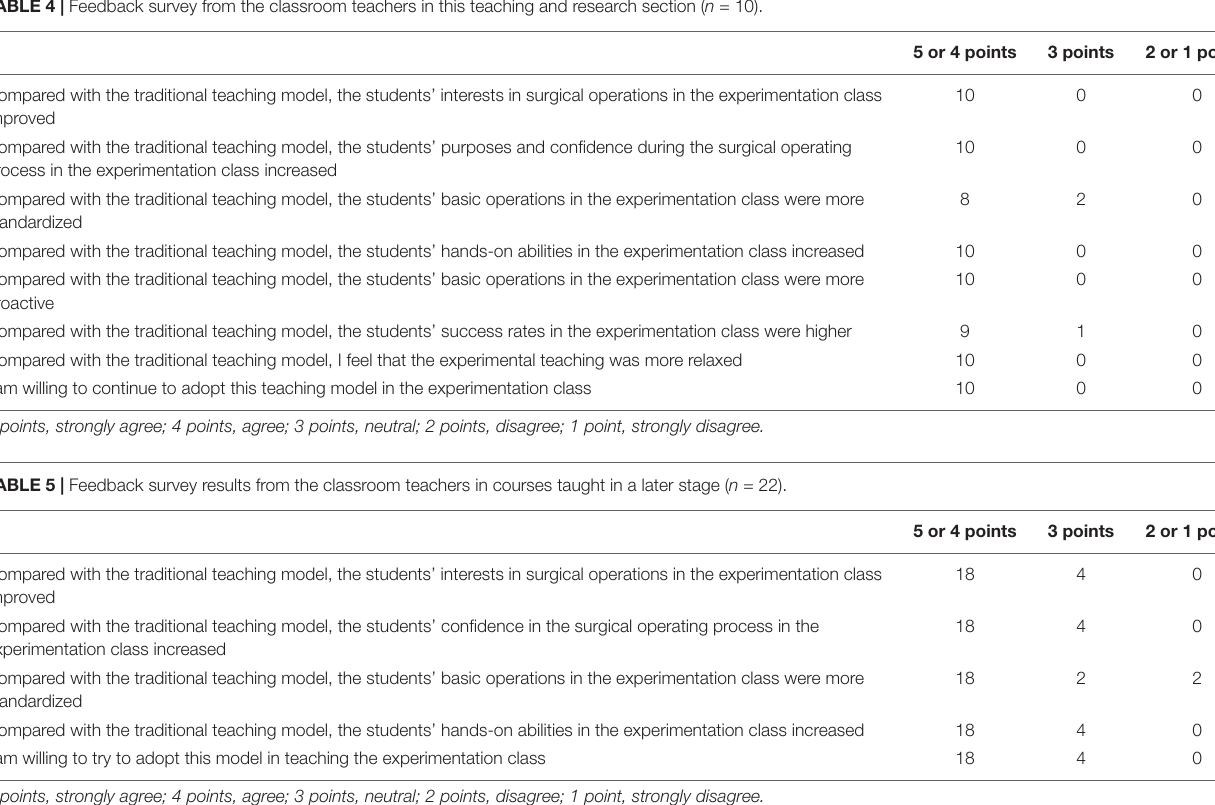
TABLE 4 | Feedback survey from the classroom teachers in this teaching and research section ( n =